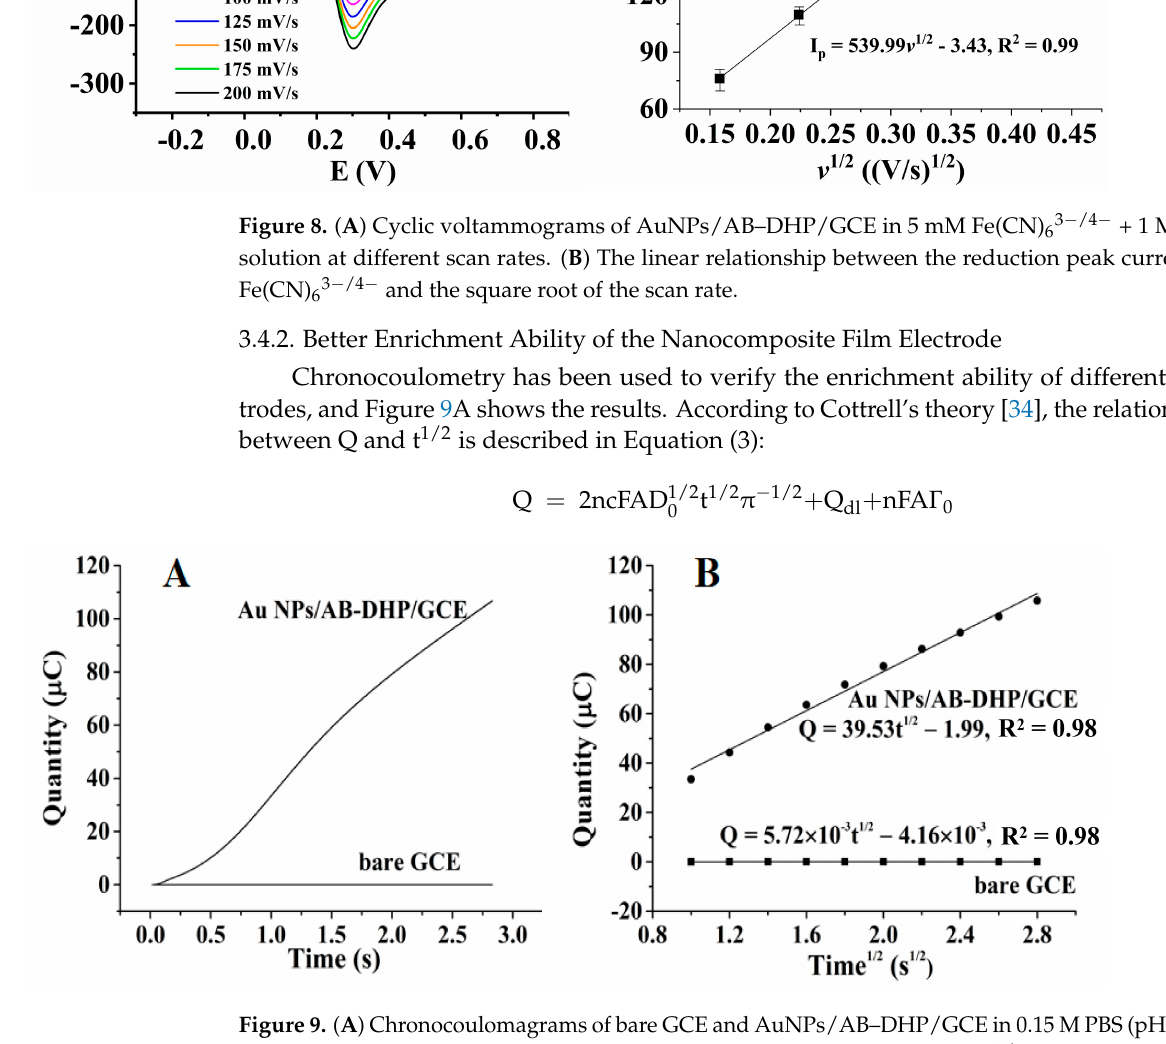
Figure 8. ( A ) Cyclic voltammograms of AuNPs/AB − DHP/GCE in 5 mM Fe(CN) 63 − /4 − + 1 M KCl solu- tion at different scan rates. ( B ) The linear relationship between the reduction peak current of Fe(CN) 63 − /4 − and the square root of the scan rate.